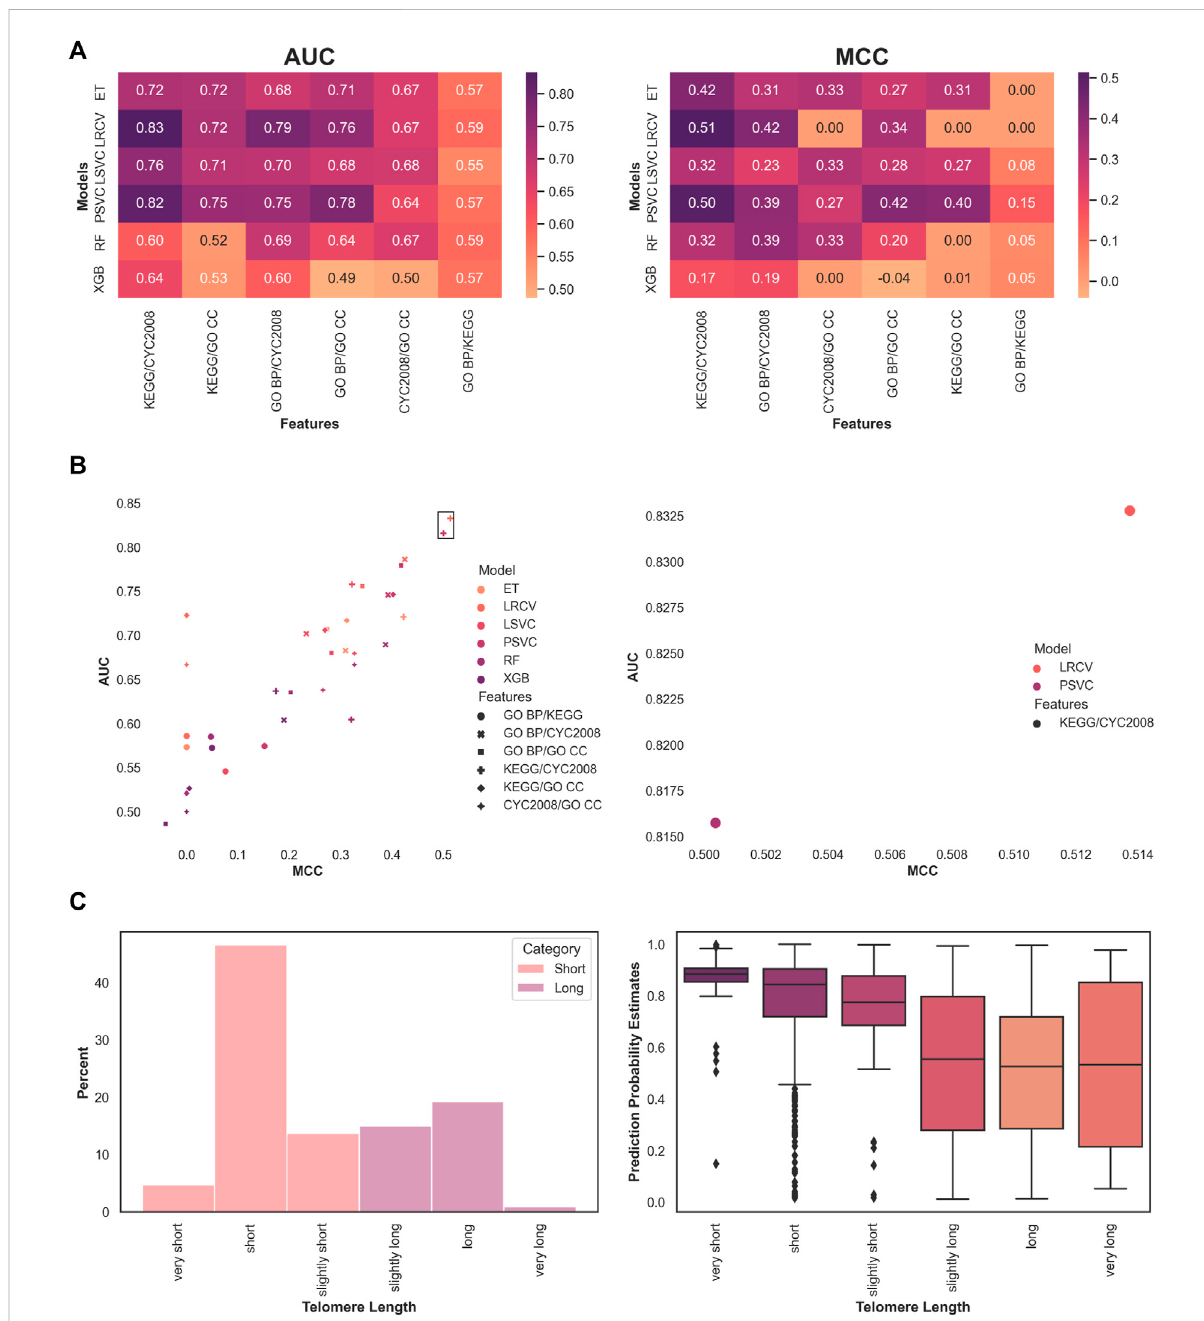
FIGURE 2 Optimalclassi fi cationofshortandlongtelomerelengthsisobtainedwithpathwayandcomplex-basedfeaturesusingalinearmodel. (A) Median model performance for each pairwise feature set. (B) Overall best performing model across features. The top two are marked by a frame and enlarged. (C) Showing the phenotype distribution of the 1170 samples analyzed for various lengths in S. cerevisiae using our system, and the probability estimates for each label across all